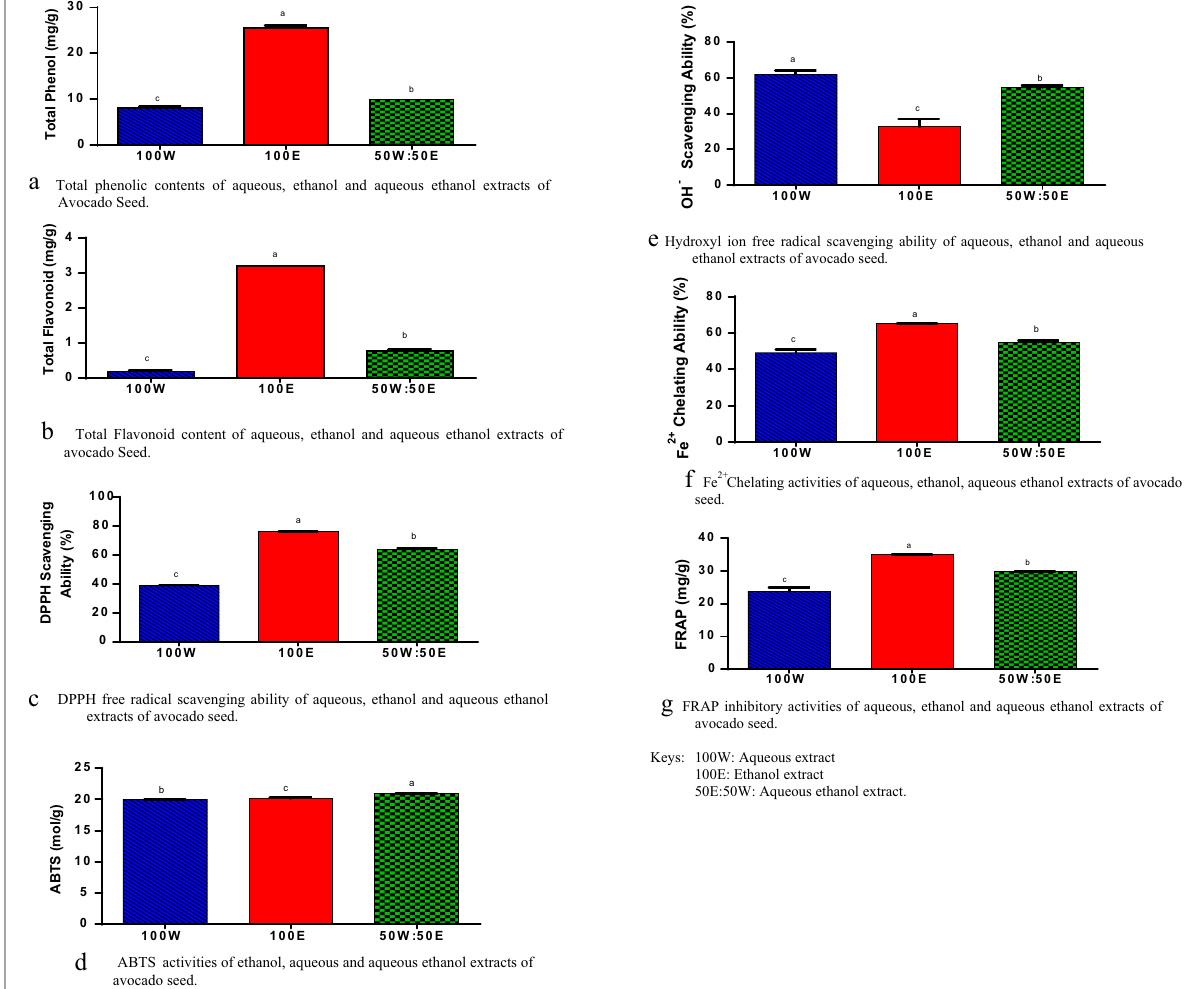
Fig.1 a Total phenolic contents of aqueous, ethanol and aqueous ethanol extracts of avocado seed. b Total flavonoid content of aqueous, ethanol and aqueous ethanol extracts of avocado seed. c DPPH free radical scavenging ability of aqueous, ethanol and aqueous ethanol extracts of avocado seed. d ABTS activities of ethanol, aqueous and aqueous ethanol extracts of avocado seed. e Hydroxyl ion free radical scavenging ability of aqueous, ethanol and aqueous ethanol extracts of avocado seed. f Fe 2 + Chelating activities of aqueous, ethanol, aqueous ethanol extracts of avocado seed. g FRAP inhibitory activities of aqueous, ethanol and aqueous ethanol extracts of avocado seed. Keys: 100 W: Aqueous extract. 100E: Ethanol extract. 50E:50 W: Aqueous ethanol